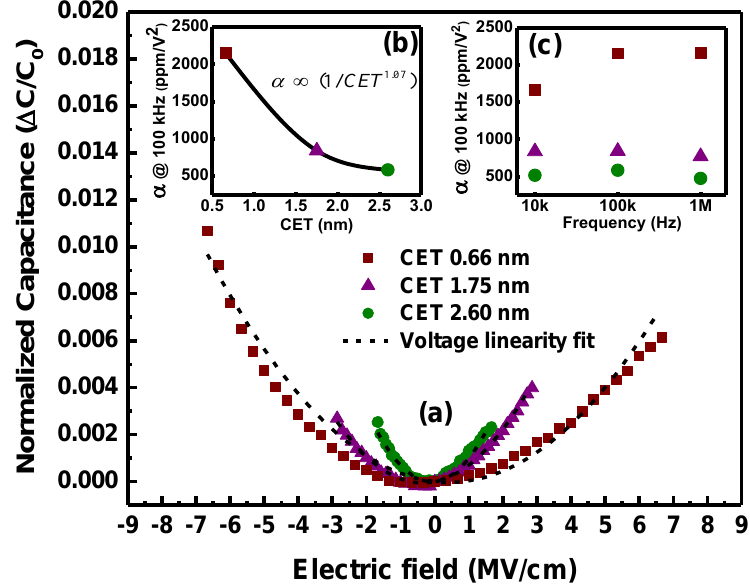
Figure 19. ( a ) The normalized capacitance as a function of applied electric field and voltage linearity fit for various LaGdO film thicknesses measured at 100 kHz. Variation in 3 the voltage coefficient of capacitance as a function of ( b ) CET at 100 kHz and ( c ) the AC drive signal frequency. Reprinted with permission from [43]. Copyright 2013 AIP Publishing LLC.